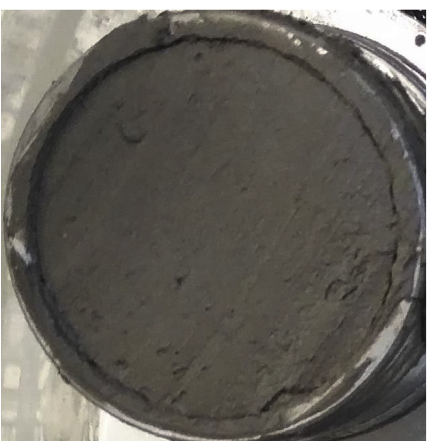
Figure 6: Photograph showing the surface of a 0.00mol/L spec- imen cured in the moisture cylinder for 28 days. Note that there are no bacterial colonies on the specimen’s surface and the specimen has shrunk and settled below the rim of the mold containing the specimen.